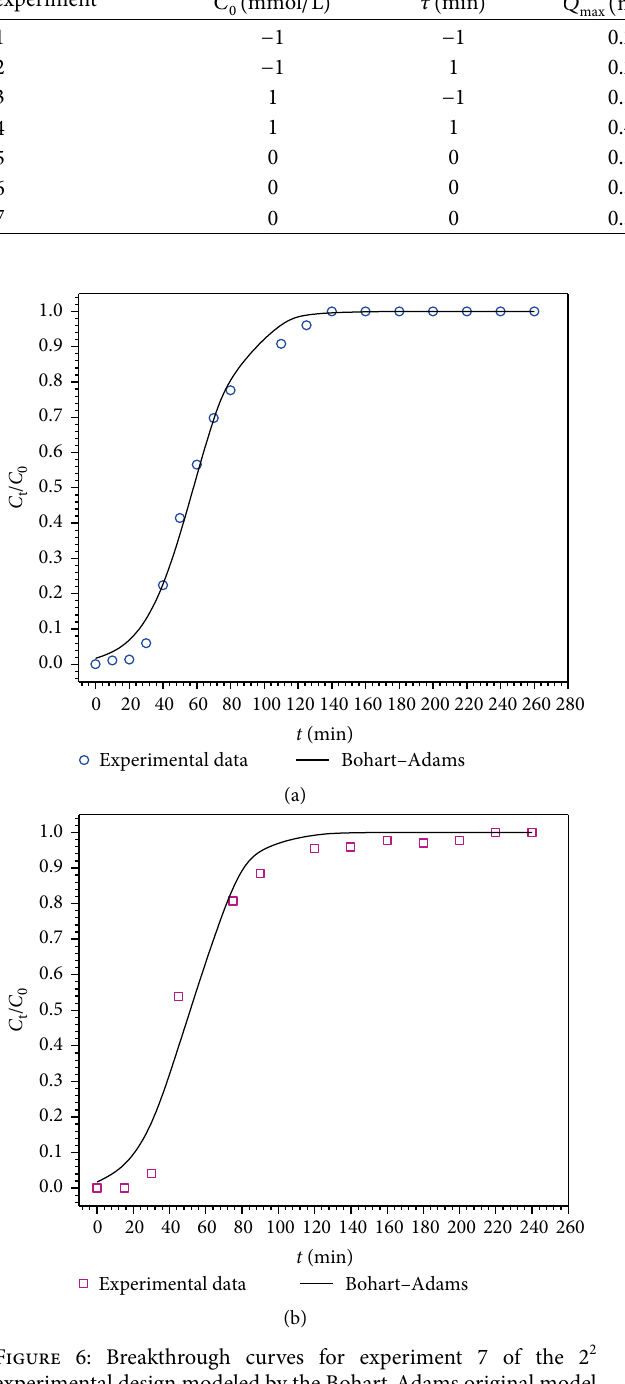
Table 5: Results of 2 2 experimental design for adsorption of Cu 2+ and Co 2+ on SBox adsorbent in a fixed-bed column at 25°C. Number of experiment